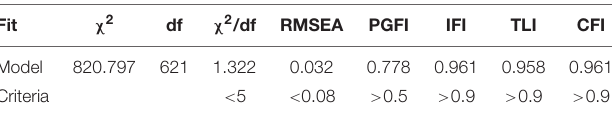
TABLE 5 | Fitting index of second order model for competitive advantage ( N = 317).